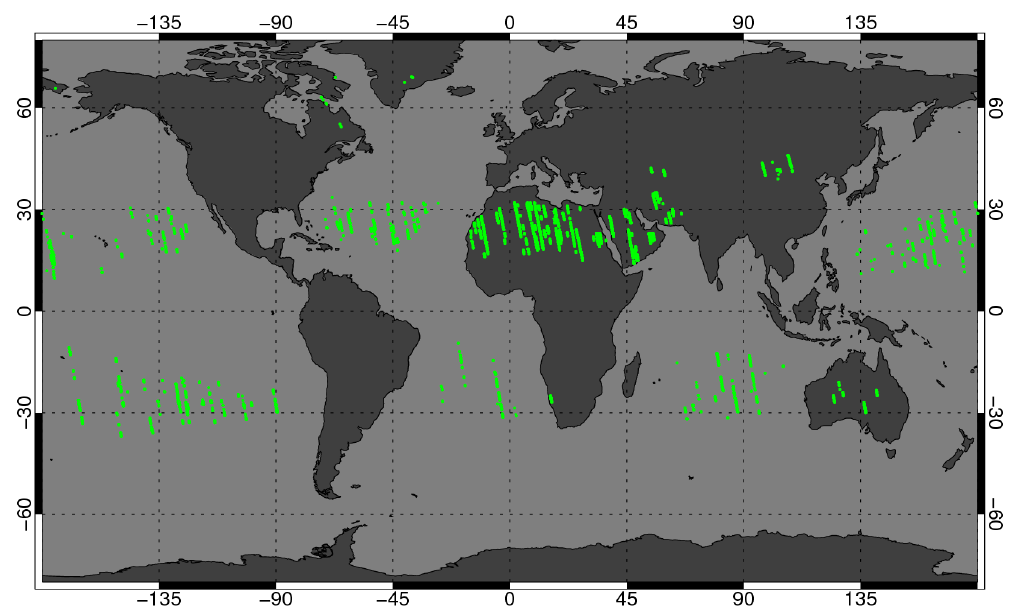
Figure 5. Sampling of all pre-filtered soundings analyzed in order to determine the ZLO correction. The data set consists of all pre-filtered OCO-2 soundings of 24 days in 2015 (13.01., 15.01., 14.02.,